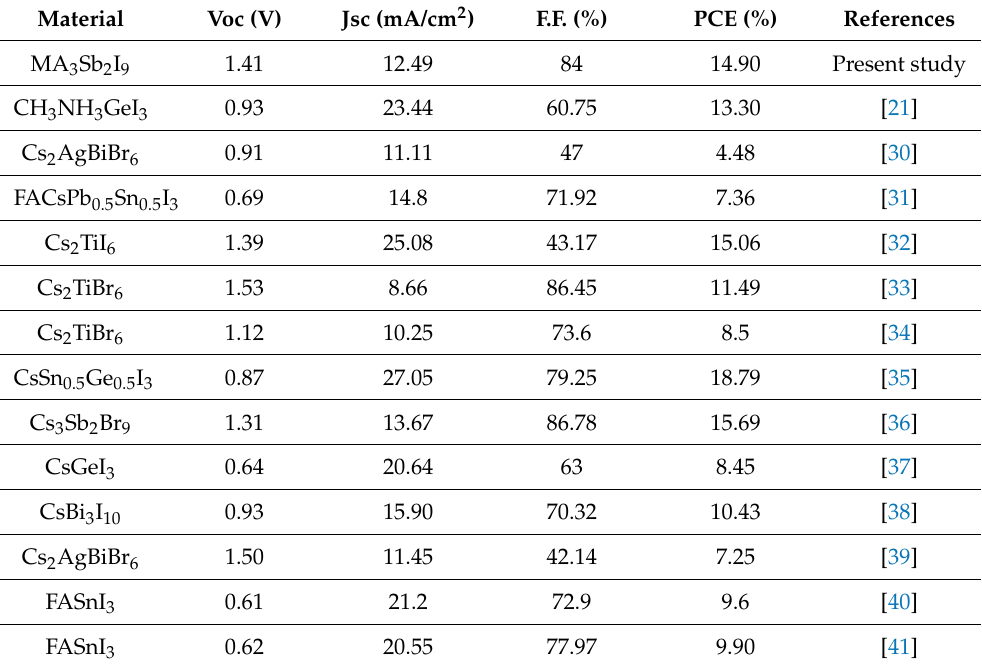
Table 1. Comparison of the Voc, Jsc, F.F., and PCE of the simulated MA 3 Sb 2 I 9- based PSCs with the recently reported articles.